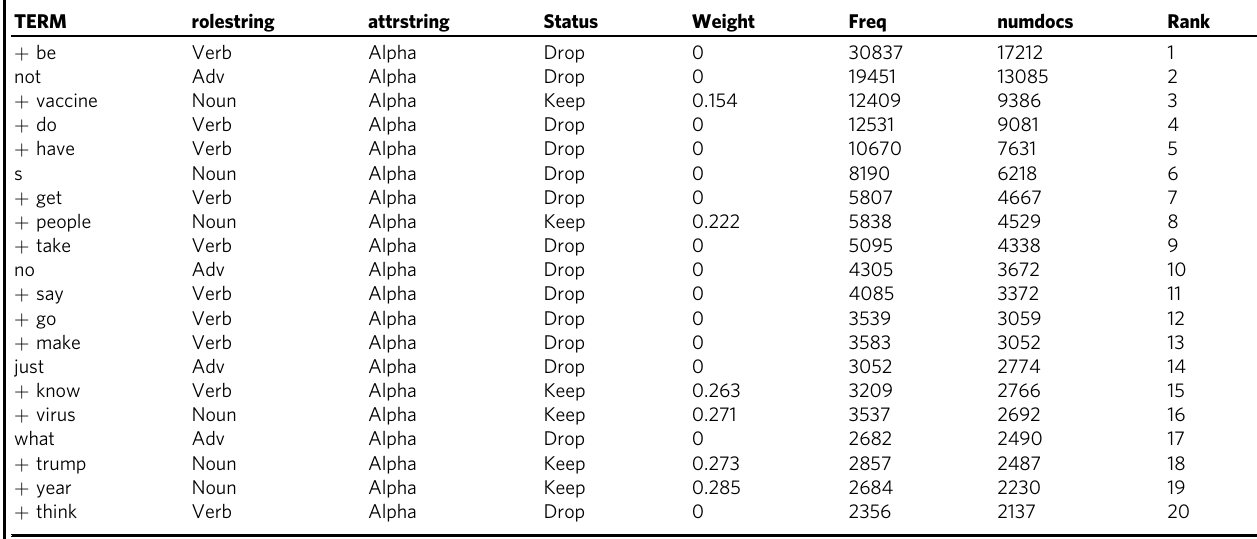
Table 2 Excerpts of the text fi lter